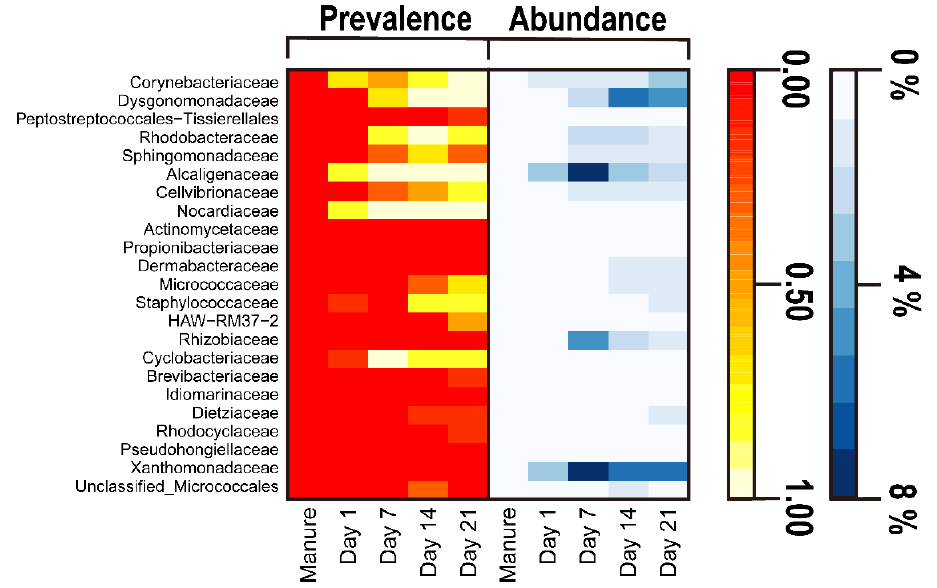
Figure 6. Heatmap showing changes in prevalence and abundance of potential odor